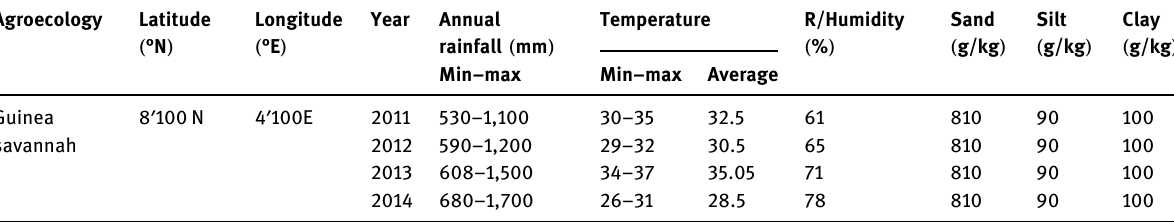
Table 1: Agro - meteorological and soil data characteristics of the experimental site ( Ogbomoso, Nigeria )